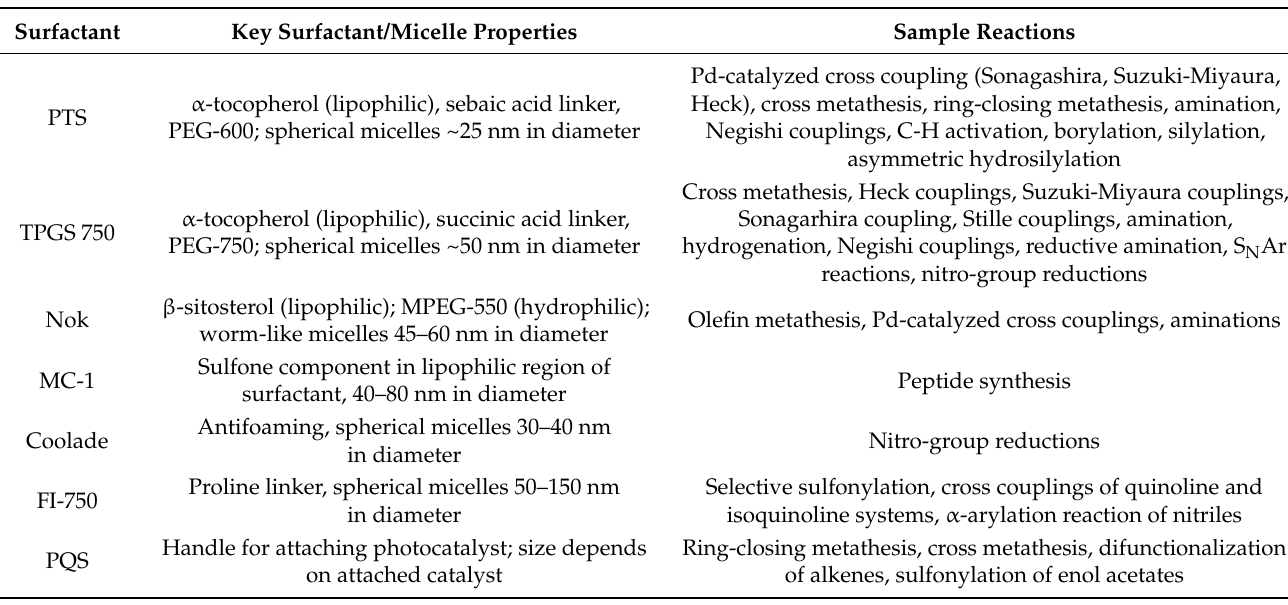
Table 3. Summary of reactions performed with various “designer”